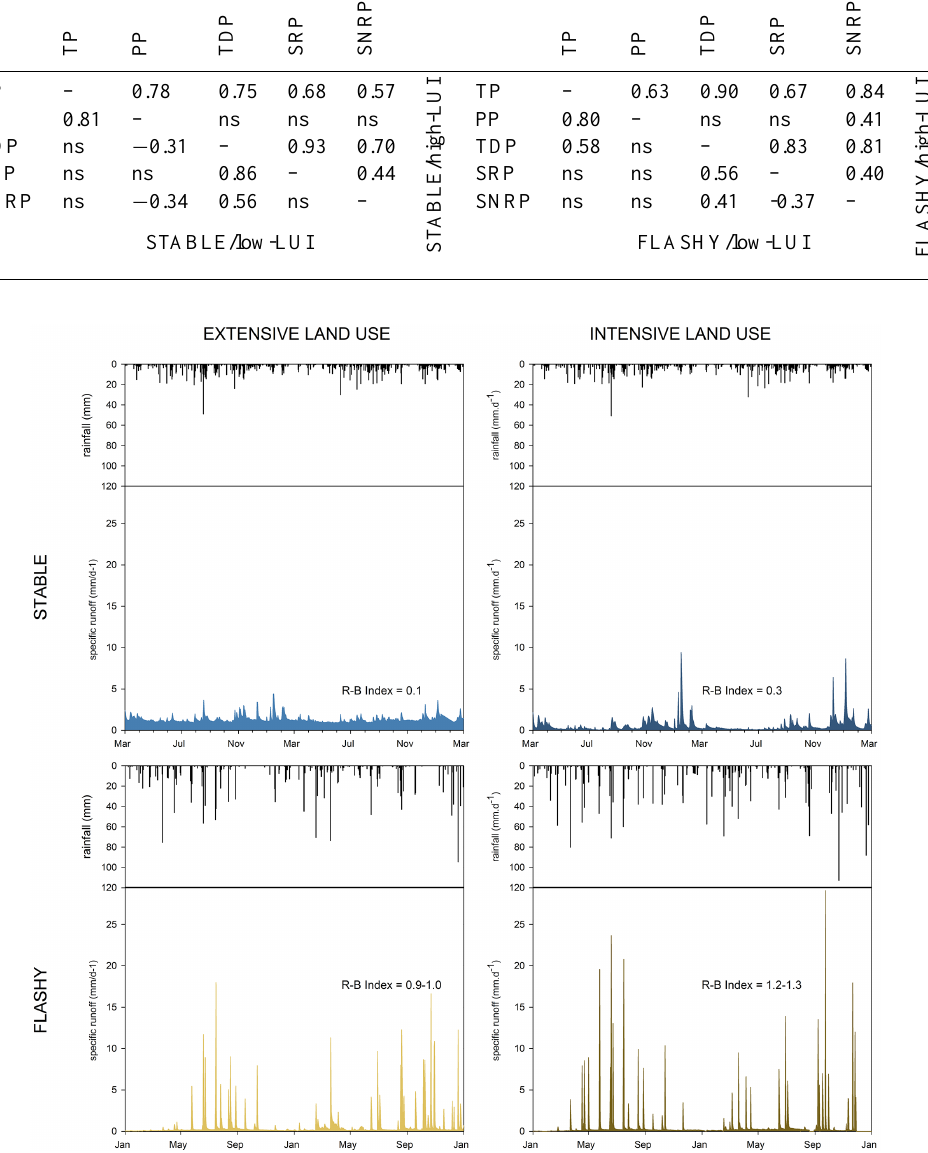
Figure 2. Accumulated daily rainfall and specific runoff hydrographs for the four monitored streams (temperate/STABLE: Danish; sub- tropical/FLASHY: Uruguayan). For each variable a fixed scale was used to aid visual comparison. R–B index (Richards–Baker index) of